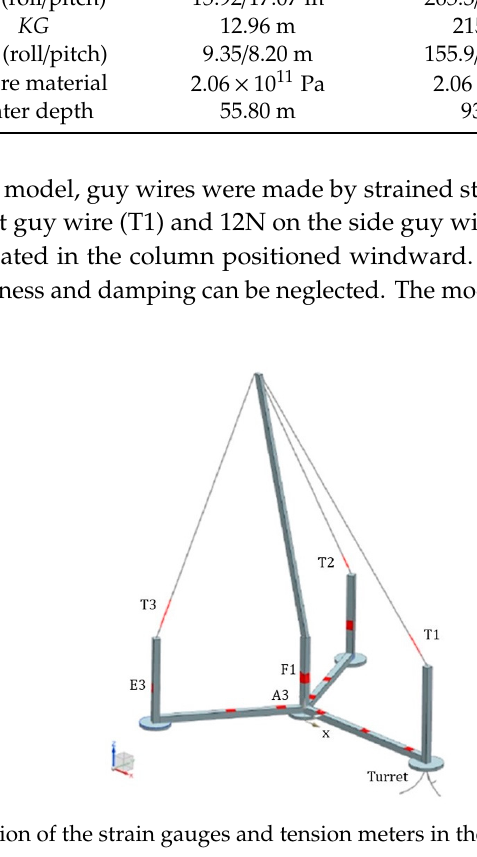
Table 4. Mooring system properties in the full scale. Material